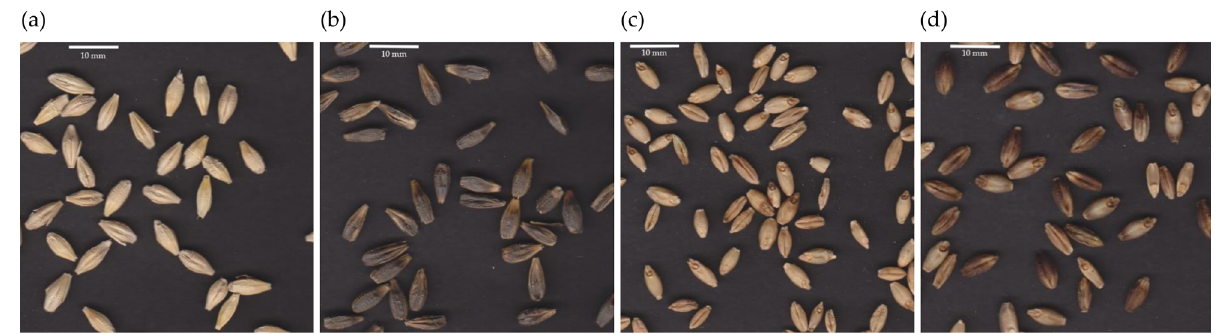
Figure 2. Grain color variation within hulled and hulless spring barley landraces: ( a ) PL 41634; ( b ) PL 502171; ( c ) PL 41867; ( d ) PL 42122.